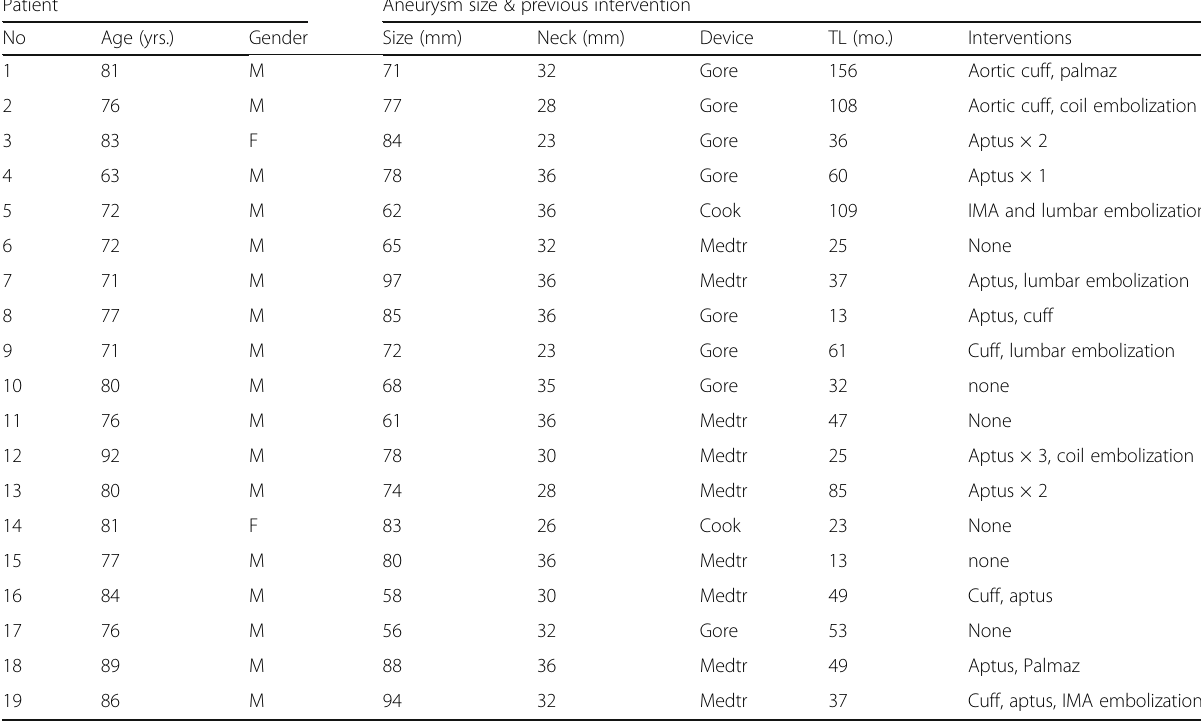
Table 2 Patient Characteristics and Preoperative Variables Patient